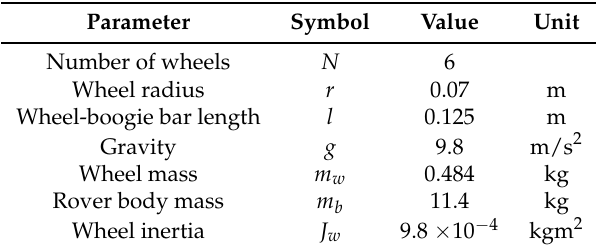
Table 1. Rover ExoTeR dynamic parameters.